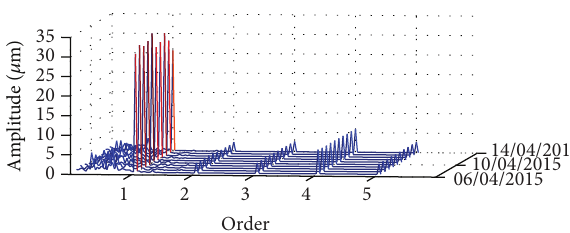
Figure 10: Results of full-vector spectrum